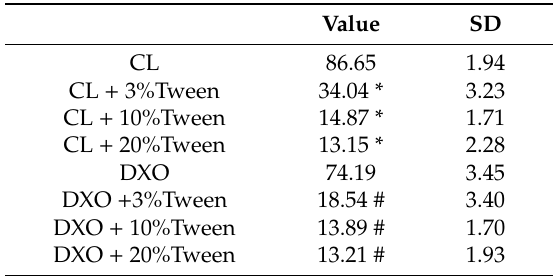
Figure 1. 3%, 10% or 20% Tween 80 decreased the contact angle of poly(LLA- co -CL) and poly(LLA- co -DXO), implying that all of the three ratios of Tween 80 could improve the hydrophilicity of the copolymers (n = 5). Table 1. The water contact angle results measured on the film